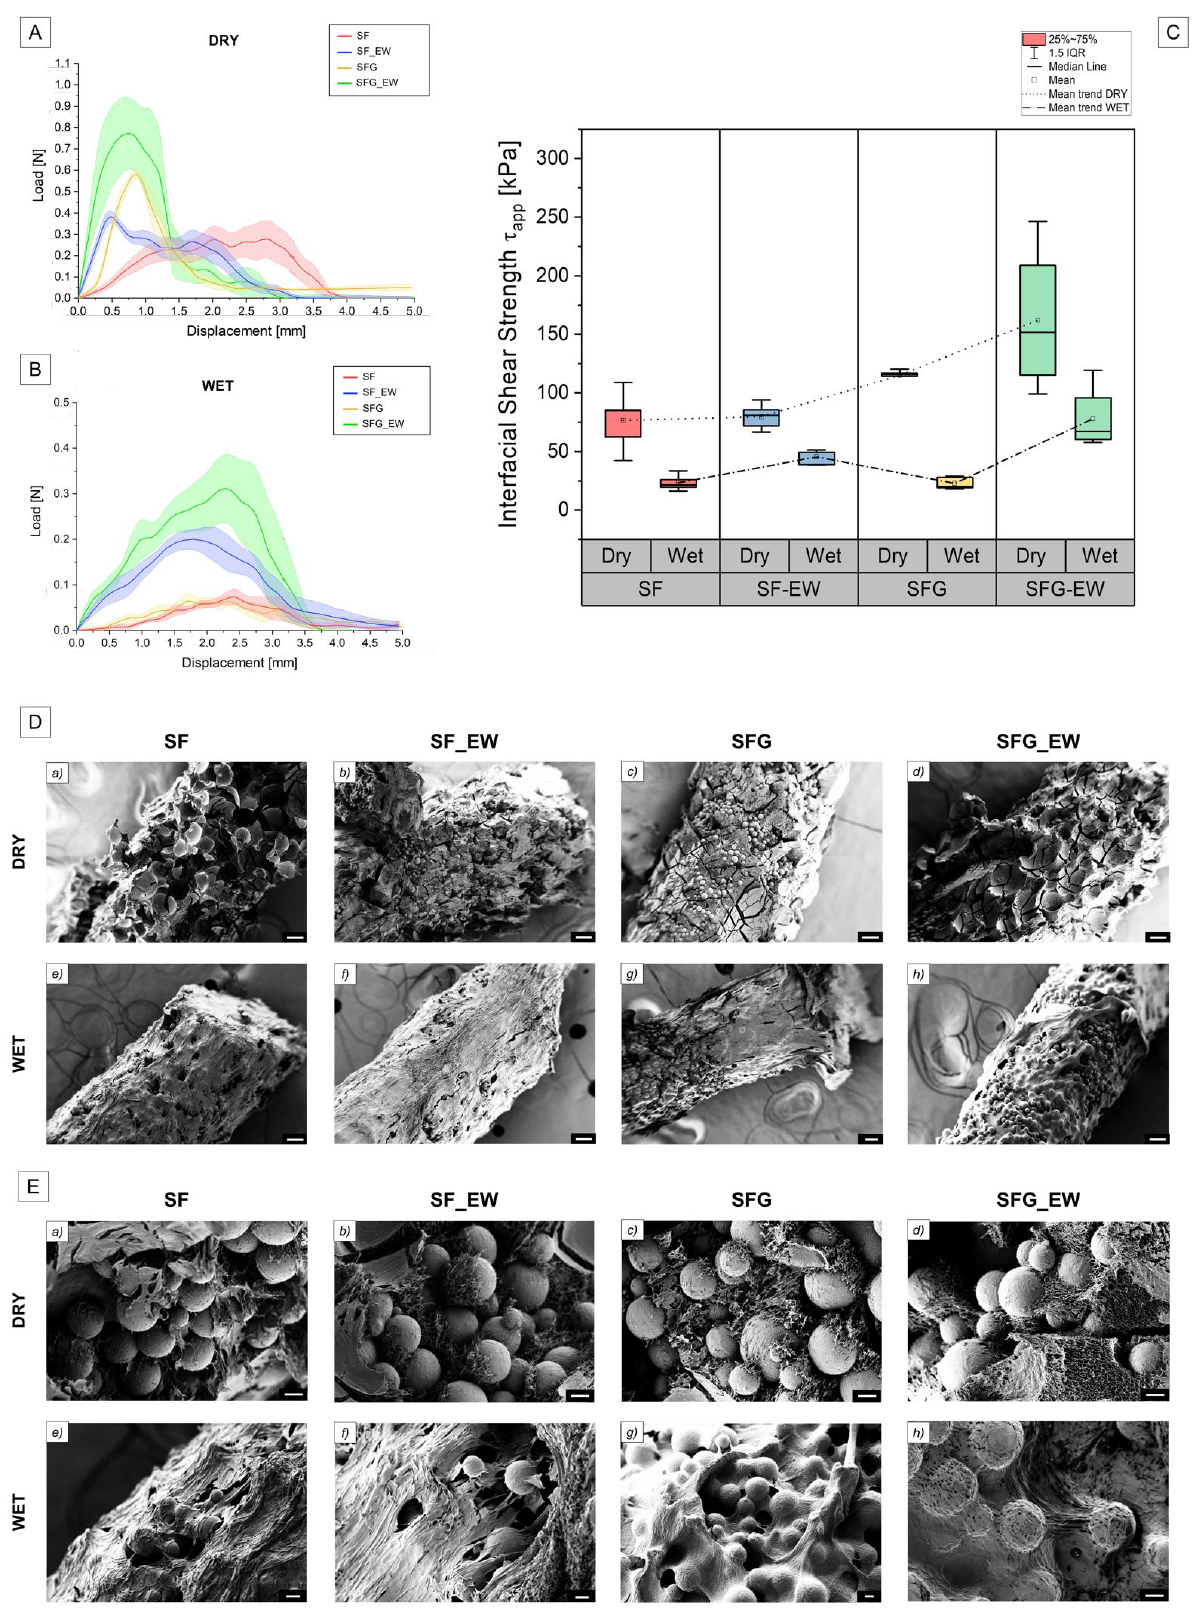
Figure 8. The averaged force–displacement curves pull-out curves for dry ( A ) and wet ( B ) conditions for the four investigated classes of specimens. Scatter bands are also represented. ( C ) Comparative boxplots, depicting the interfacial shear strength values against the four different classes of